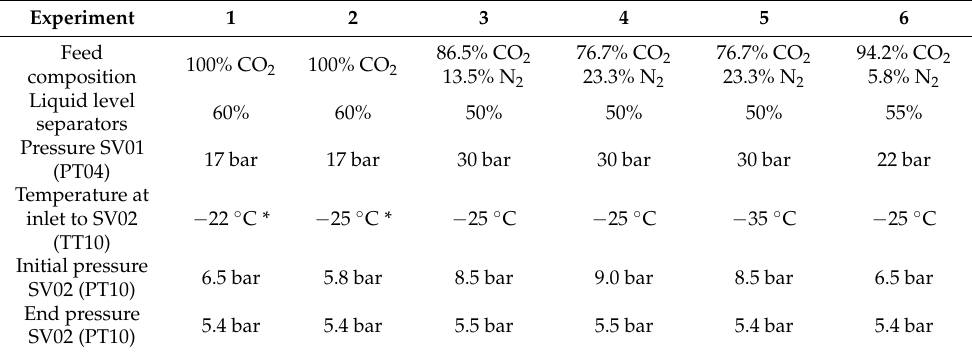
Table 3. Settings and parameters for experiments